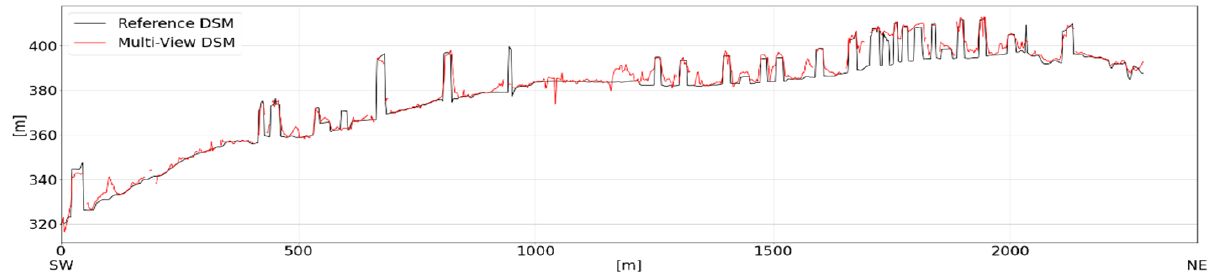
Figure 10. Section extracted from the reference DSM and the DSM generated with the multi-view approach.